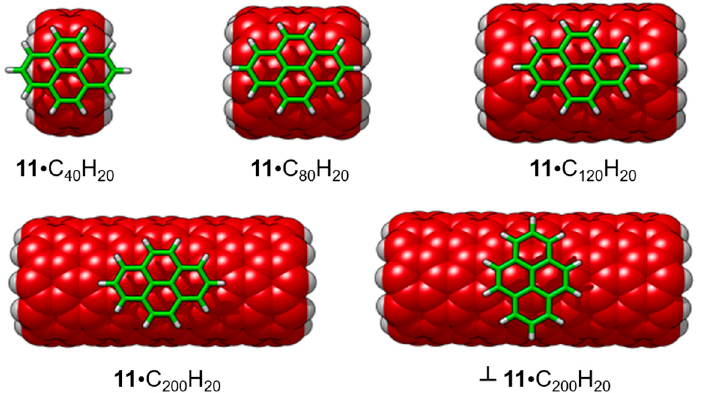
Figure 23. Minimum-energy geometries of parallel 11 • SWNT assemblies and the perpendicular 11 • C 200 H 20 calculated at the PBE0-D3/6-31G** level from a semi-rigid optimization with fixed intramolecular parameters (see the original Reference [117] for further details). Carbon atoms of SWNTs are highlighted in red whereas the carbon atoms of pyrene are in green. Hydrogen atoms are depicted in white. Reproduced from Reference [117] with permission from the Royal Society of Chemistry.